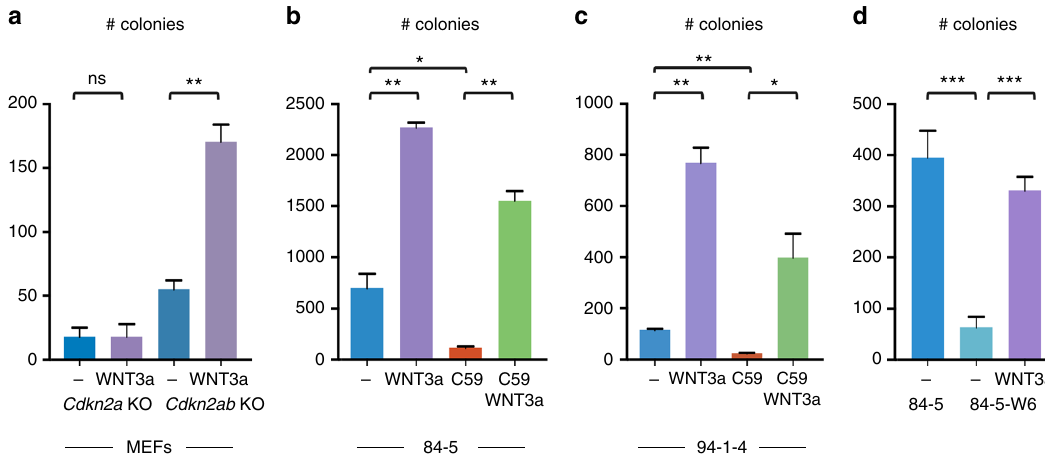
Fig. 6 Validation of functional involvement of WNT7b in the transformed nature of MEFs and skin tumour cell lines. a Anchorage-independent colony outgrowth of Cdkn2a KO and Cdkn2ab KO MEFs with and without WNT3a supplementation. b Anchorage-independent colony formation of tumour cell lines 84-5 under regular ( − ) conditions, in the presence of WNT3a supplementation, in the presence of the porcupine inhibitor C59, in the presence of C59 and WNT3a supplementation. c Anchorage-independent colony formation of tumour cell line 94-1-4 under regular ( − ) conditions, in the presence of WNT3a supplementation, in the presence of the porcupine inhibitor C59, in the presence of C59 and WNT3a supplementation. d Anchorage-independent colony formation of tumour cell lines 84-5 and 84-5-W6 knockout for Wnt7b with and without Wnt3a supplementation. Statistical analysis (Unpaired t -test): ns: not signi fi cant, * p < 0.05, ** p < 0.01, *** p < 0.001. Error bars represent standard error of the mean (3 biological